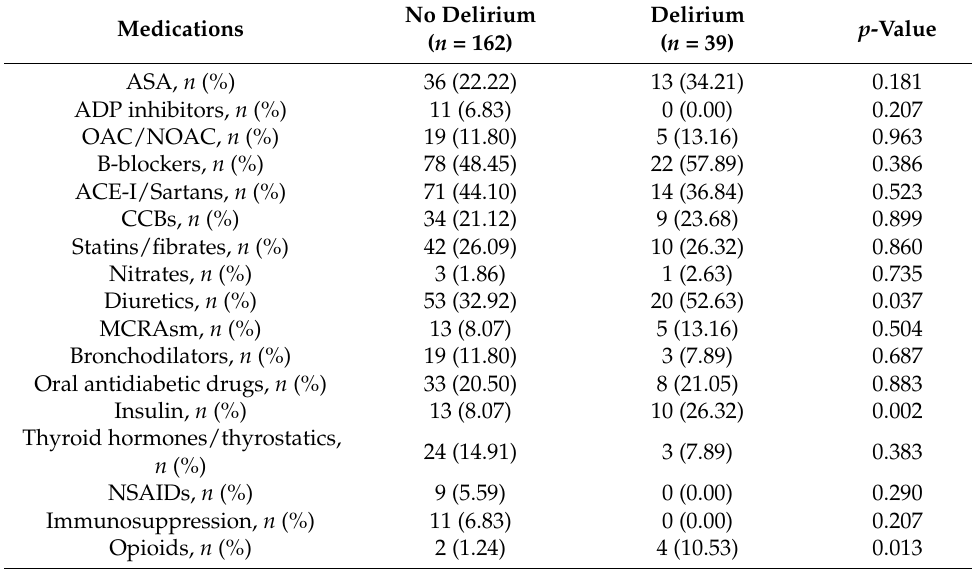
Table 2. Regular medications taken by the patient prior to admission.